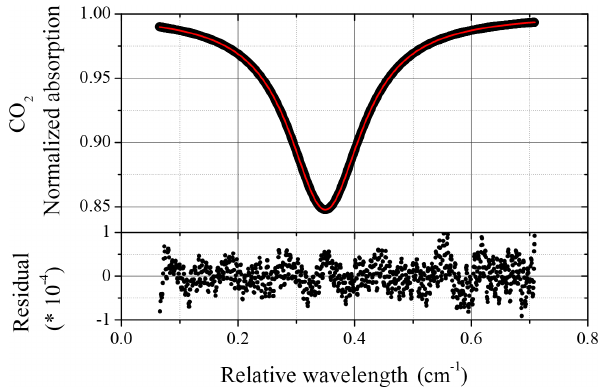
Figure 5. Normalized absorption spectra of a CO 2 calibrated mix- ture (of about 590ppm in synthetic air) around 4989.97cm − 1 (2004.02nm) and Voigt fit results (red line). The residuals of the fitting procedure are shown in the bottom plot. The integration time is 0.25s. The measurement was carried out at ambient pressure and at a temperature of